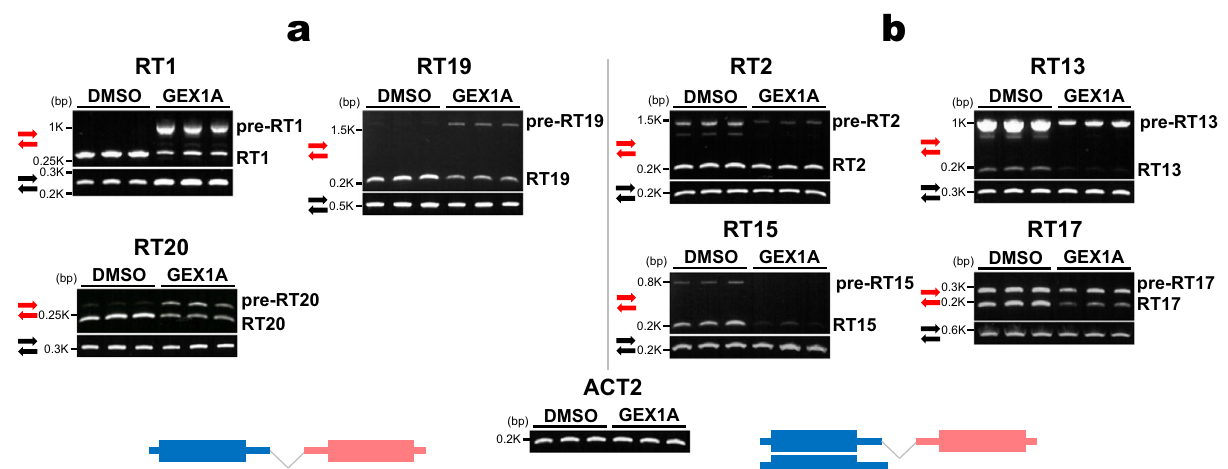
Fig. 4 Splicing inhibitor treatment assay in Arabidopsis seedlings. The results were divided into two speci fi c types, a and b . n = 3 biologically independent samples. a Pre-RTs undergoing intron retention increased but mature RTs decreased under the inhibitor (RT1, RT19 and RT20). b Both pre-RTs and mature RTs decreased (RT2, RT13, RT15 and RT17). The red primer pair ampli fi es the IS intron-containing joint region between the fi rst and second genes, while the black primer pair ampli fi es the intron-less region of the fi rst genes. Three biological replicates were performed. ACT2 was used as an internal control. The difference between the two types, a and b , is shown in the lower